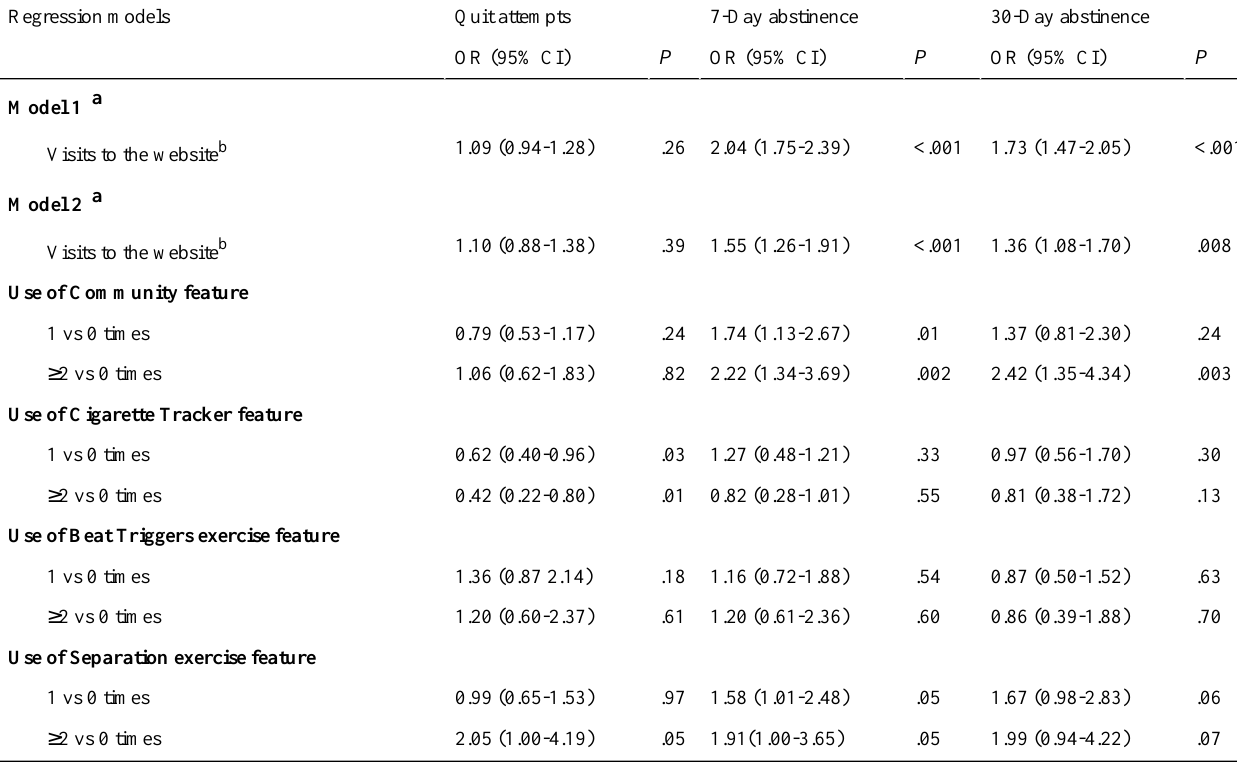
Table 3. Association between website usage and quit behavior over time using generalized estimating equations